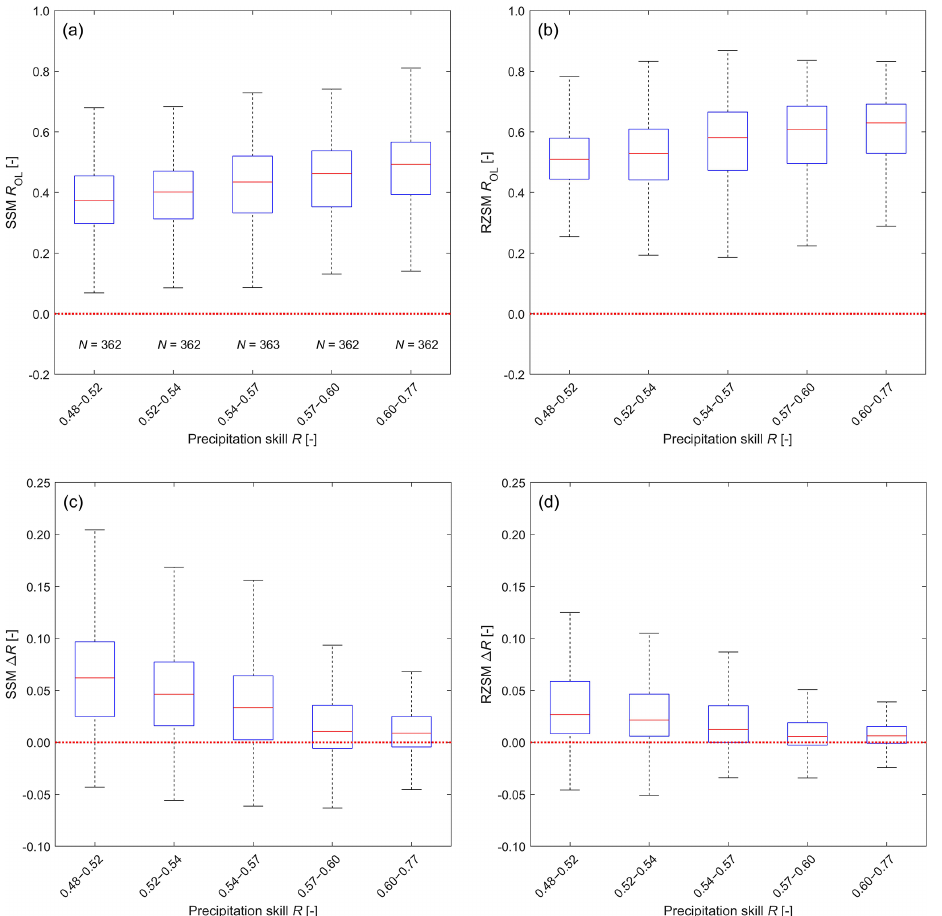
Figure 7. OL performance ( R OL ) as a function of precipitation forcing skill R for (a) SSM and (b) RZSM. SMAP L4 DA skill improve- ment ( (cid:49)R = R L4 − R OL ) as a function of precipitation skill for (c) SSM and (d) RZSM. Samples with precipitation skill ranking below the 20th percentile are excluded from the analysis.